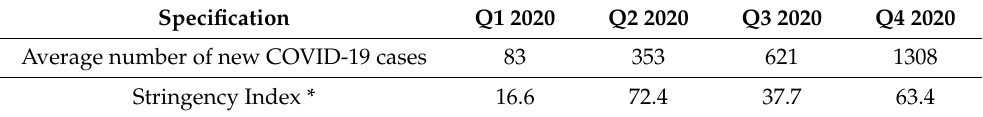
Table 2. Dynamics of new COVID-19 cases and the relevant policy responses in